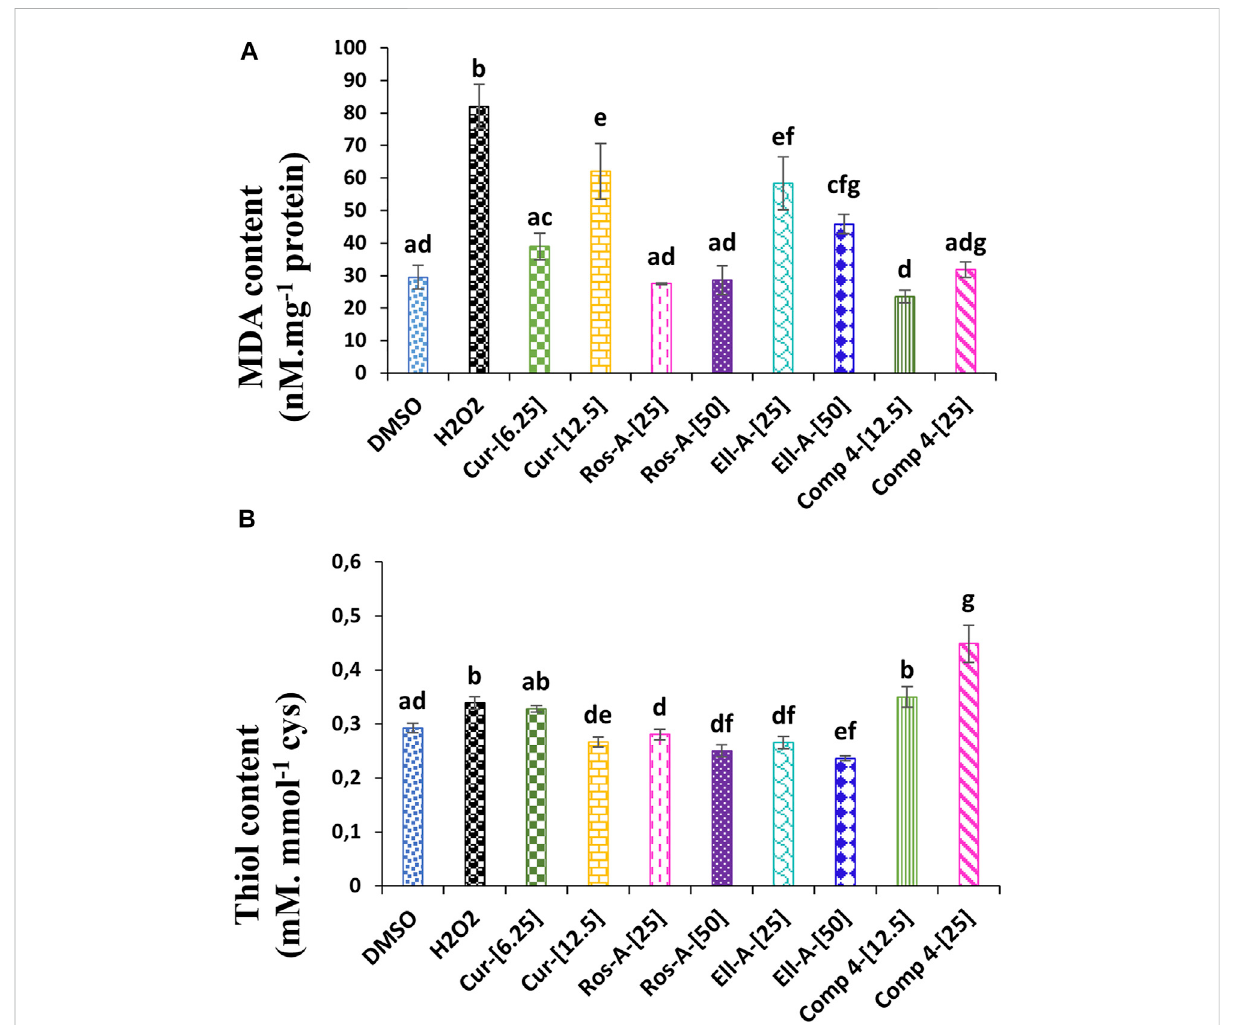
FIGURE 2 EffectofCur,ROS-A, Ella-AandComp-4,inTHP-1cellstreatedwithH 2 O 2 ,on (A) MDAcontentand (B) thiolcontent.Eachvaluerepresentsthe mean of three replicate. Bars represent standard error. Different letters indicate signi fi cant differences among treatment at p <